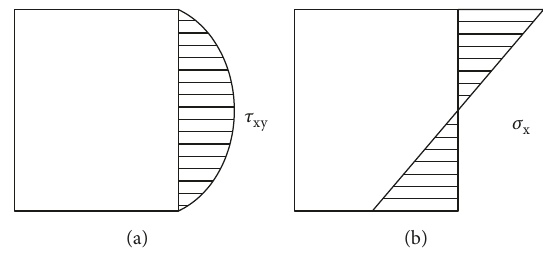
Figure 3: Internal force of pile. (a) Shear stress; (b) normal stress.